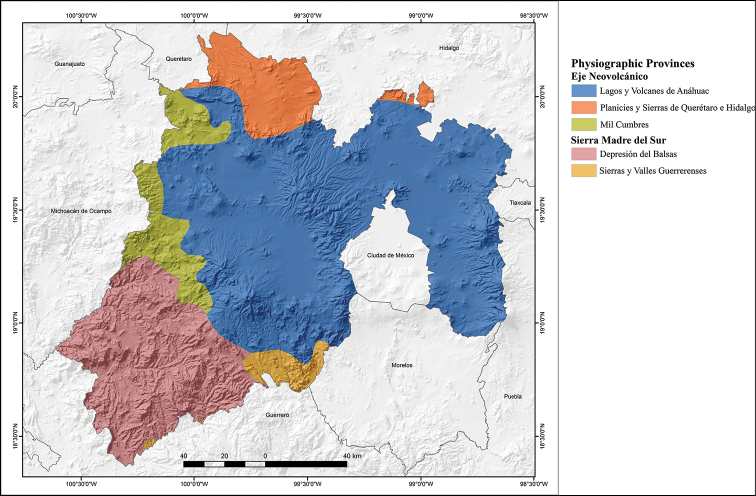
Physiographic provinces of the State of Mexico, Mexico (modified from Cervantes-Zamora et al. 1990).